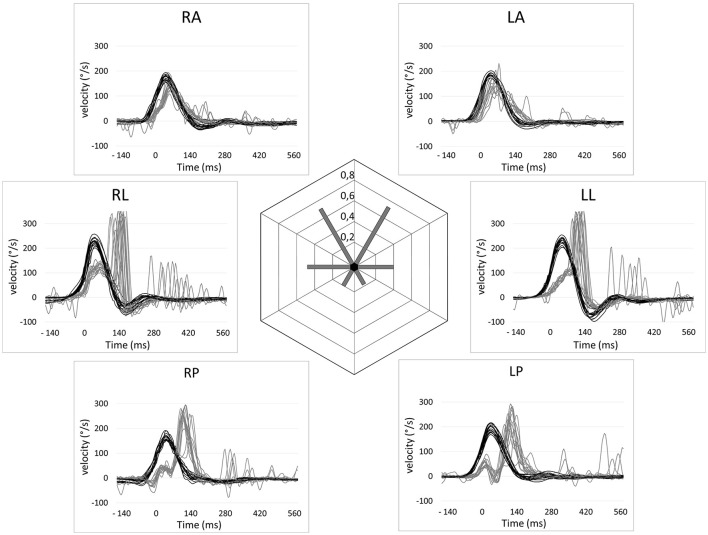
Video head impulse test recordings of a patient with a gentamycin-induced bilateral vestibular hypofunction showcasing a relative sparing of the anterior semi-circular canal function. Eye velocities (gray lines) and head velocities (black lines) relative to time are shown for the six semi-circular (RA, Right anterior; LA, Left anterior; LL, Left lateral; LP, Left posterior; RP, right posterior; RL, right lateral). Residual VOR gains are shown in the center.